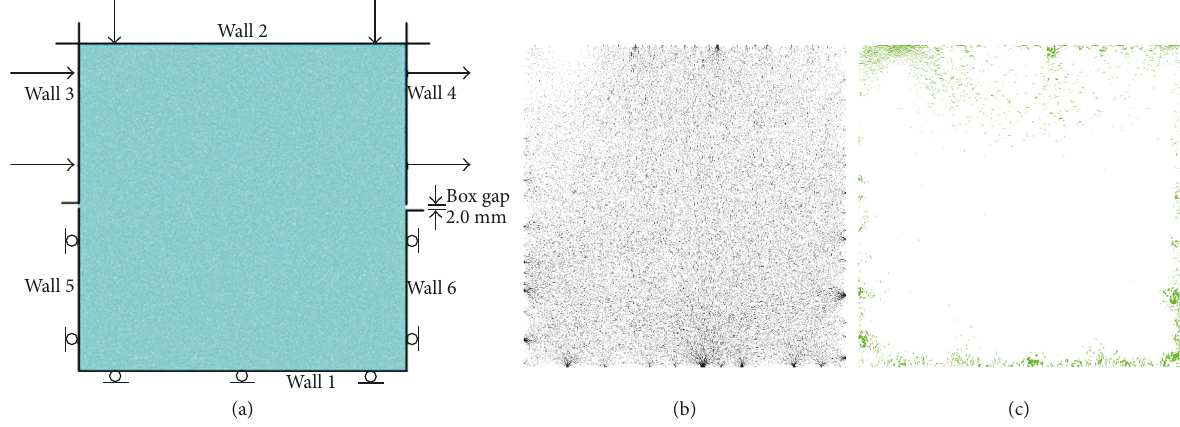
Figure 3: Intact numerical model: (a) schematic diagram of direct shear setup; (b) compressive contact force chain; (c) tensile contact force